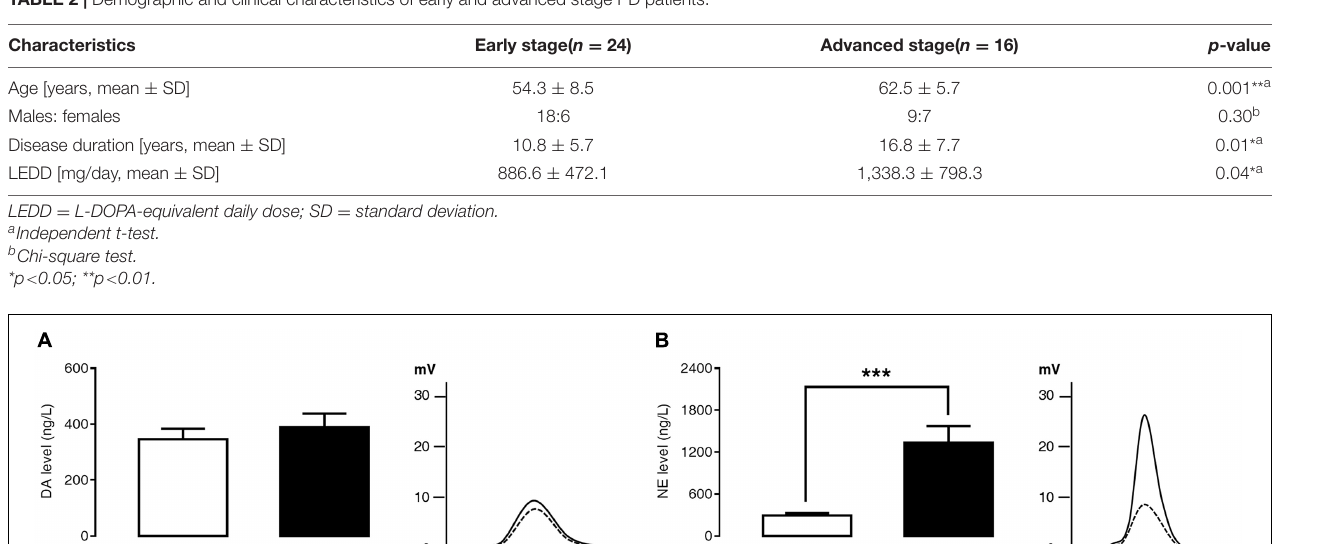
TABLE 2 | Demographic and clinical characteristics of early and advanced stage PD patients.